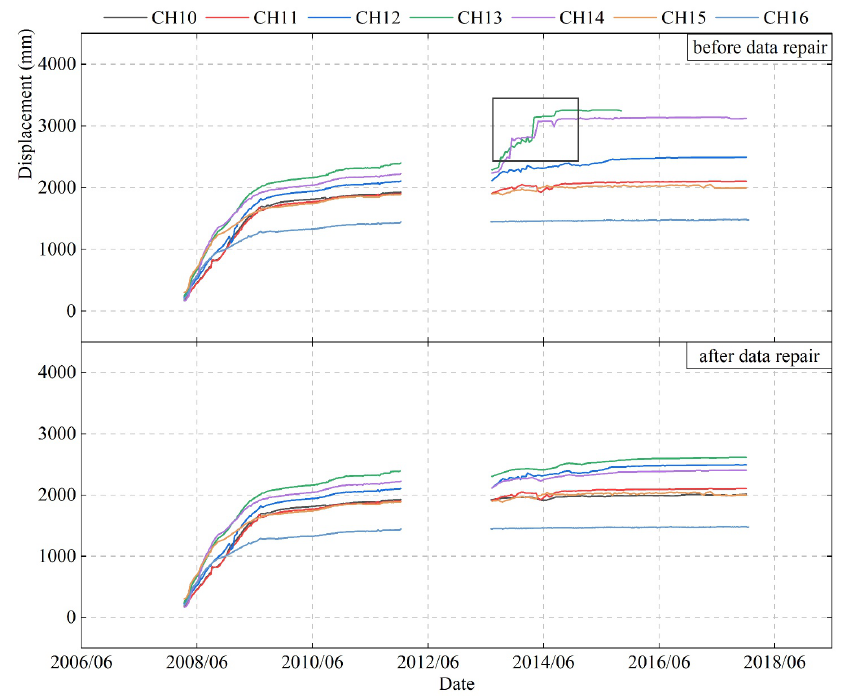
Figure 12. Duration hydrograph of the hydraulic overflow settlement gauge at 725 m elevation at profile 0+240 m.